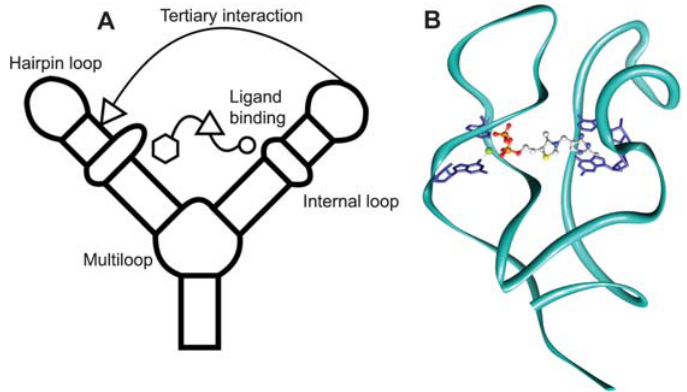
Figure 1 Loops in RNA structure. (A) Interactions and structural elements in a TPP-riboswitch aptamer domain (98). A-helical base-paired regions are given as rectangles, loops as curve drawings. (B) Ribbon-visualisation of the 3D sugar-phosphate backbone trace (turquoise) of the TPP-riboswitch aptamer domain. Bases involved in ligand binding are depicted in dark blue, the TPP-ligand is coloured by atom type. Molecular graphics were generated with Chimera